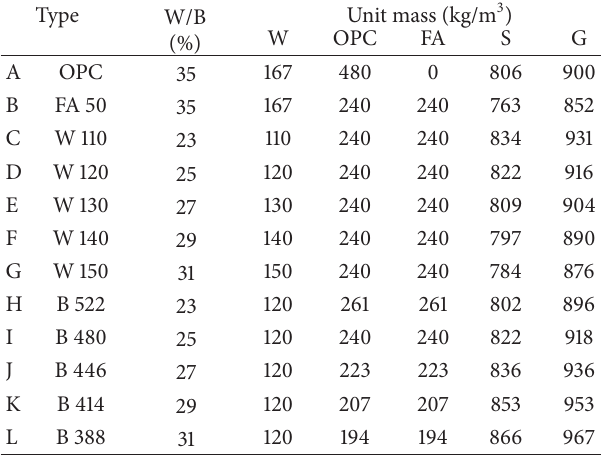
Table 3: The proportion of high volume fly ash